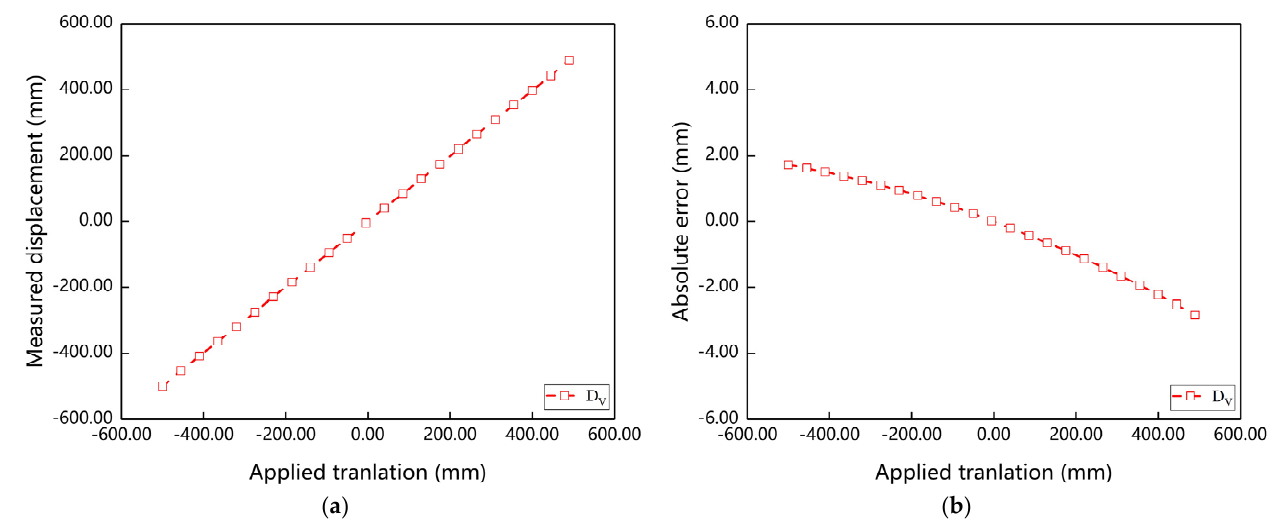
Figure 9. Vertical displacement correction results: ( a ) measured displacement after correction; ( b ) absolute error.